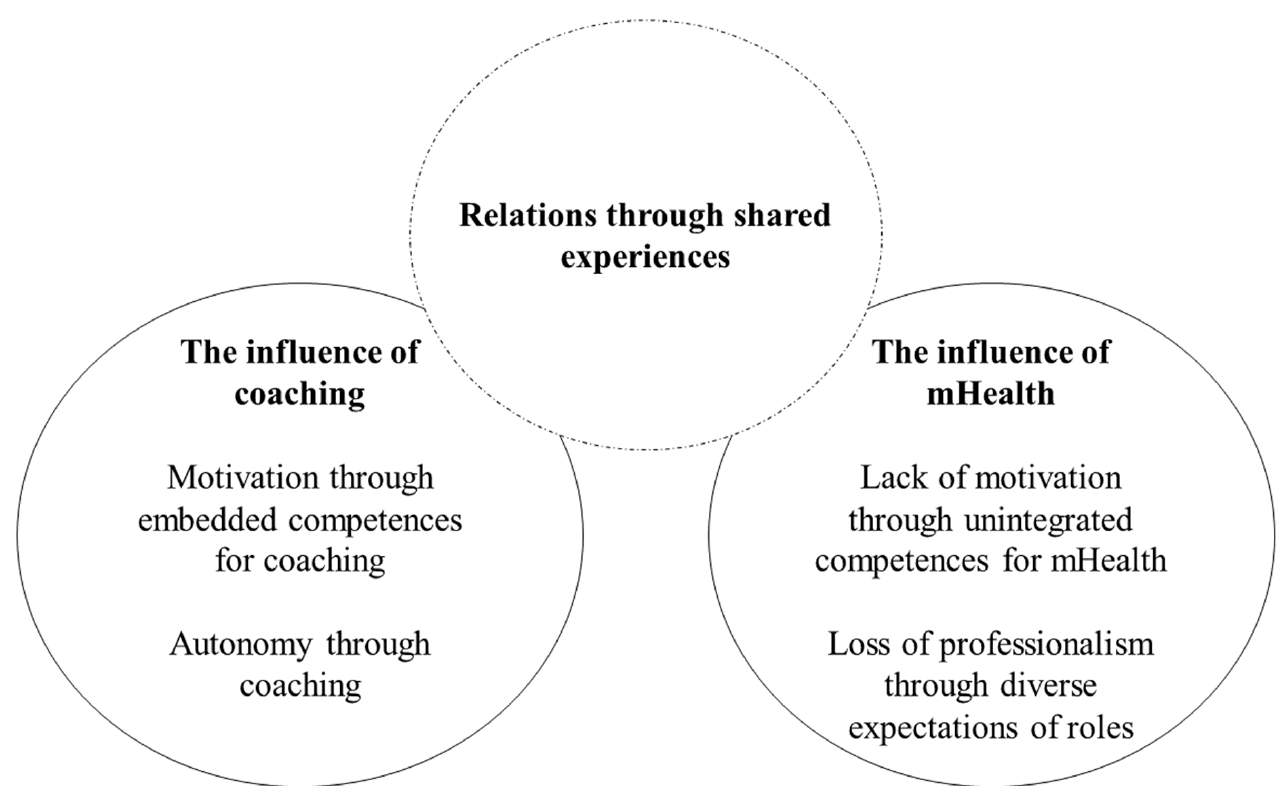
Figure 4. The three overarching and interacting themes.